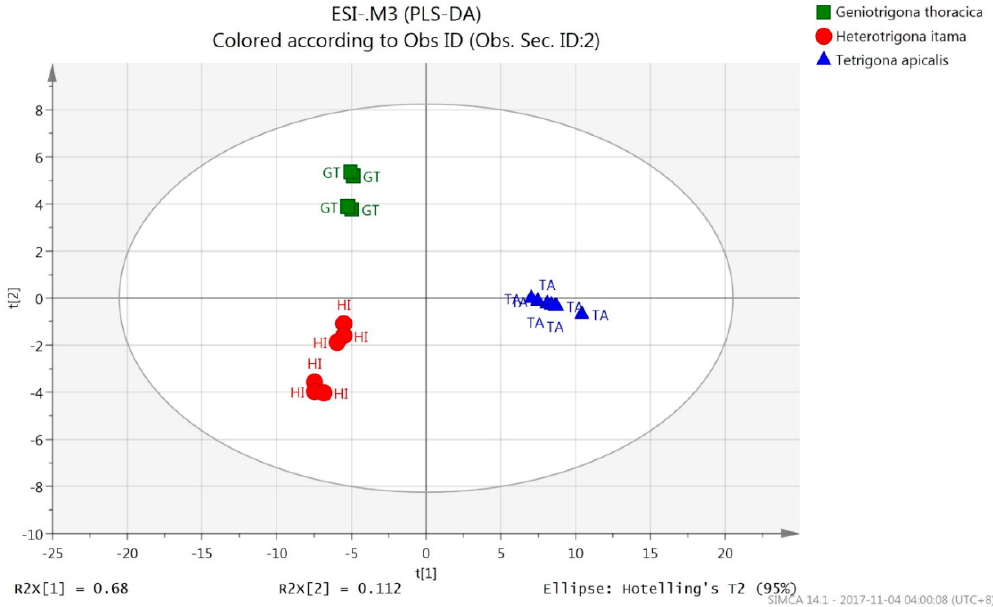
Figure 3. PLS-DA score scatter plot of for m / z values of ESI − precursor ions by UHPLC-QTOF MS data.